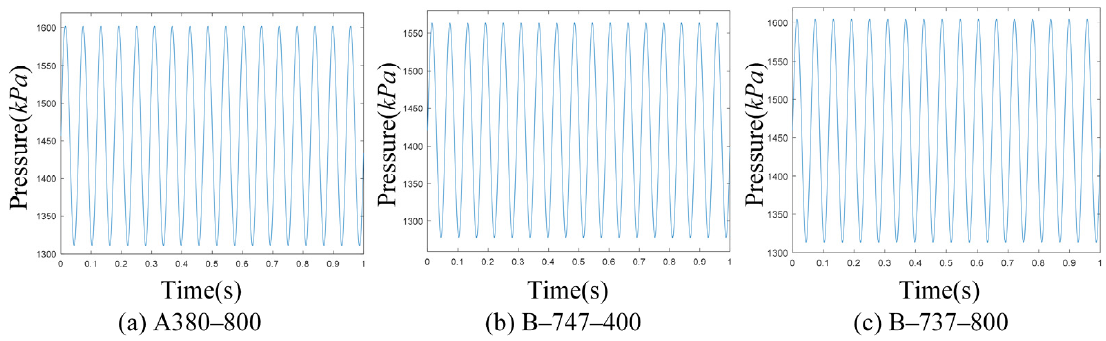
Figure 4. The pressure–time curves of aircraft main landing gear.